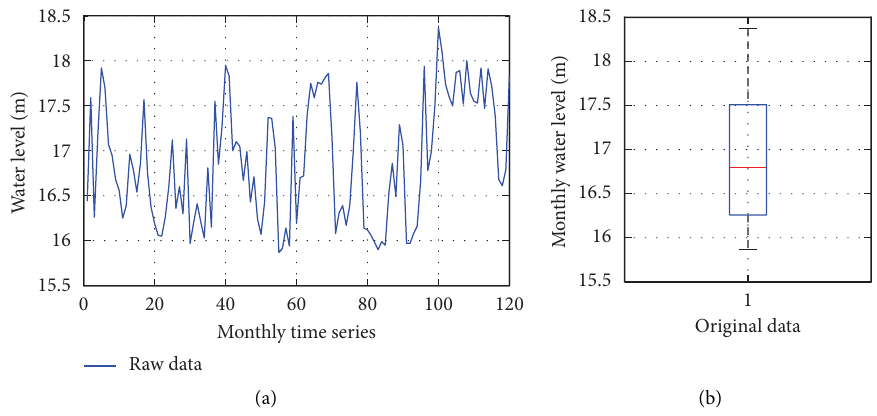
Figure 2: (a) Monthly time series and (b) box plot for water